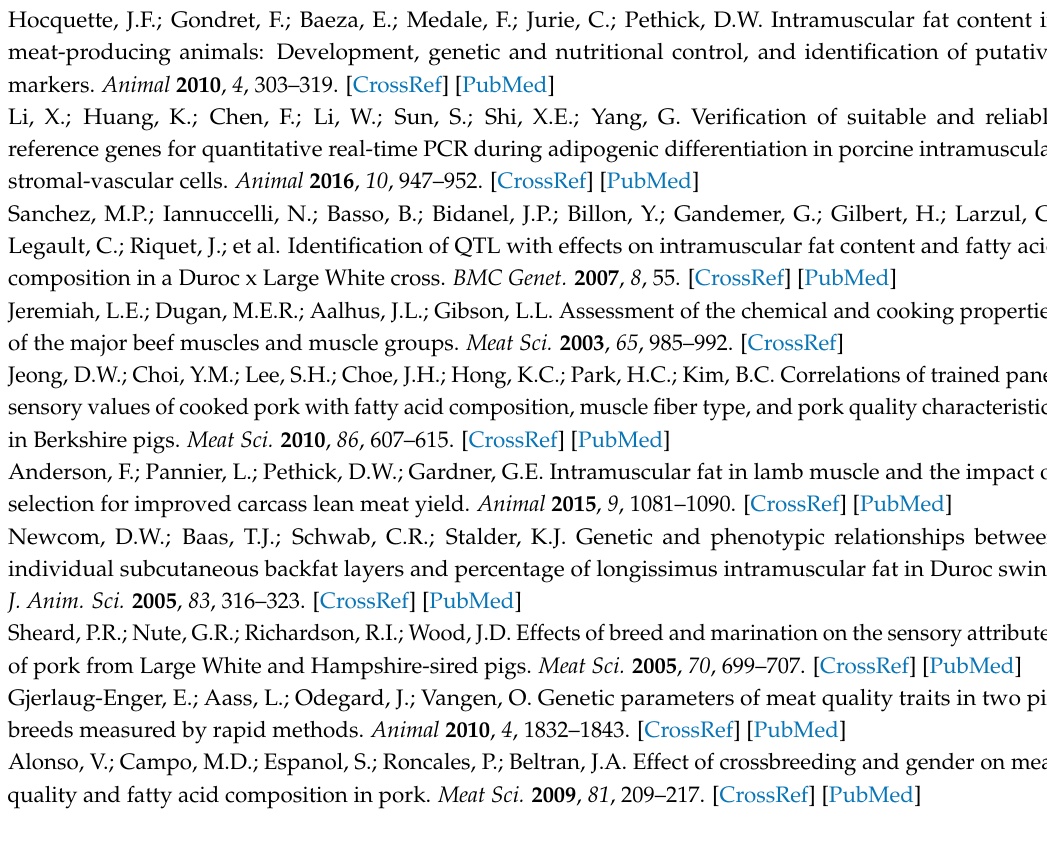
Figure S1: Graphical abstract of experimental design; Table S1: Primers used in this study; Table S2: Statistical analysis of IMF content (%) of 279 individuals; Table S3: Genes expression level in all samples; Table S4: Summary of DEGs; Table S5: List of GO term enrichment of DEGs; Table S6: List of pathway enrichment of